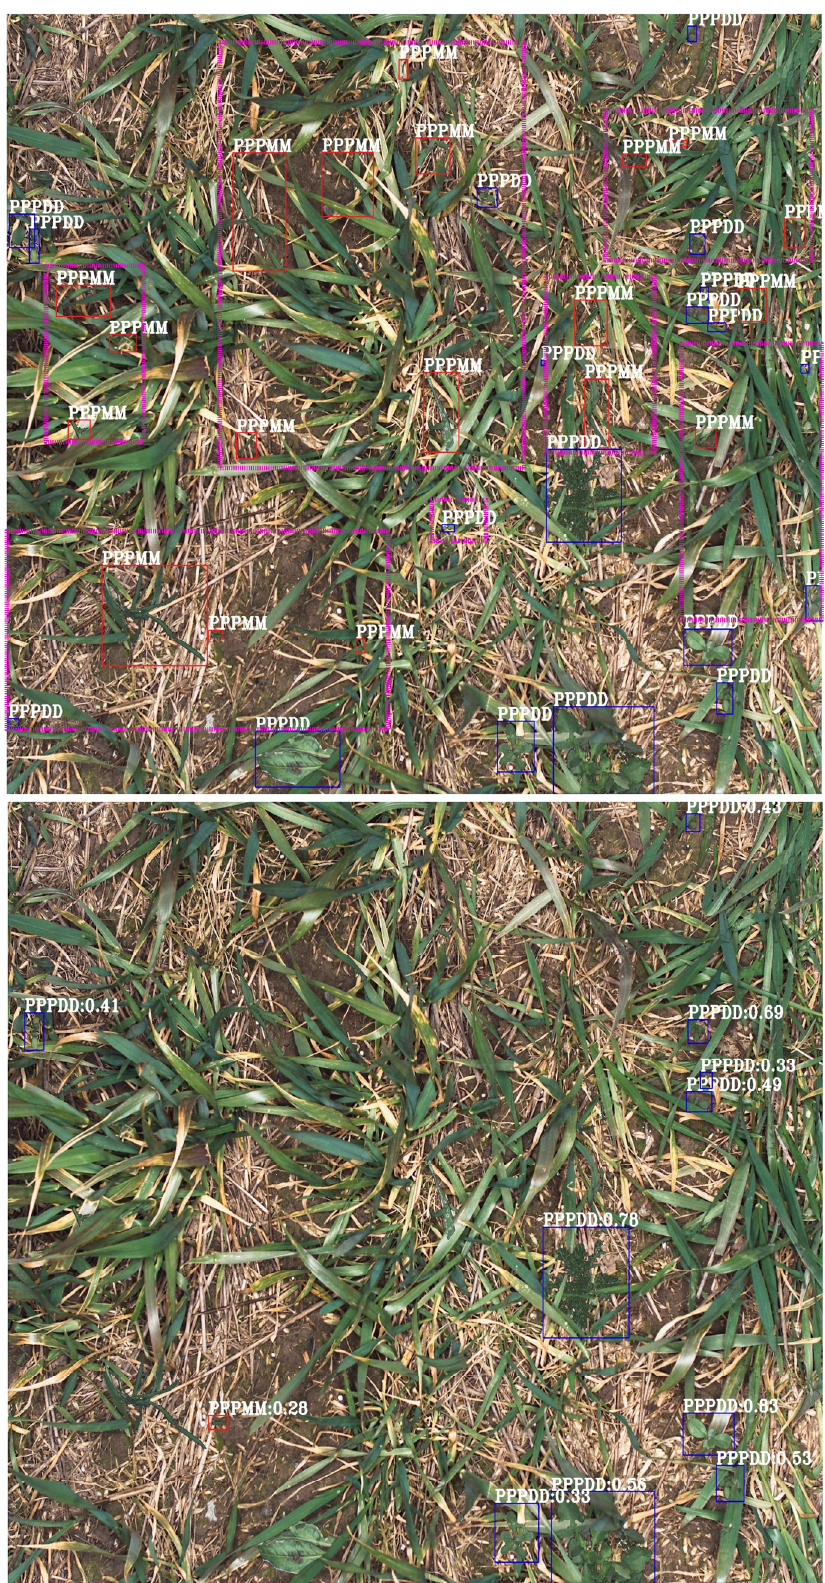
Figure 10. The EfficientDet results in a random synthetic image. Top : the label, and Bottom : the prediction. In this Figure, red and blue continuous rectangles represent TP monocot and TP dicot respectively; pink dash rectangles show FN of M/D and yellow dash rectangle is FP of M/D.